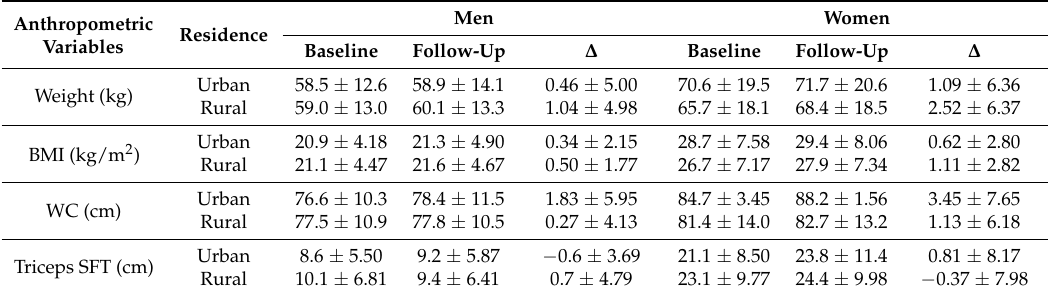
Table 2. Changes in adiposity over five years stratified by sex and residence.